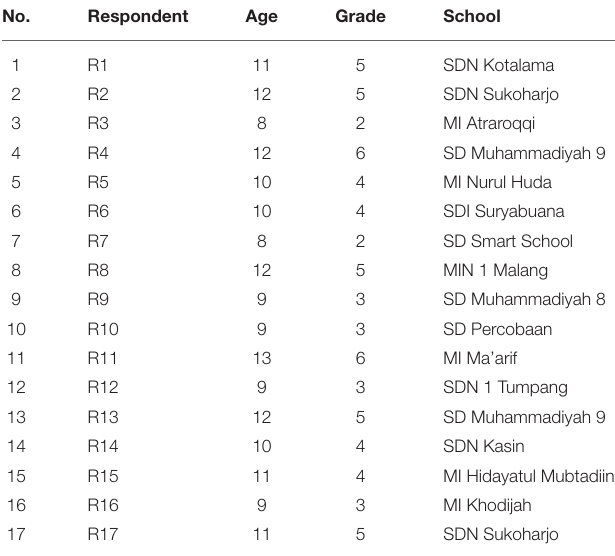
TABLE 1 | Data of